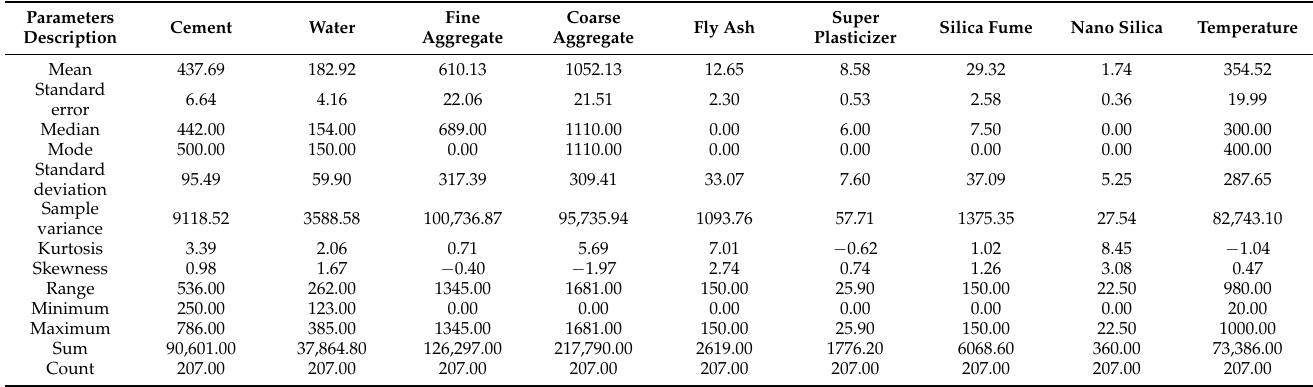
Table 2. Descriptive analysis of the parameters.